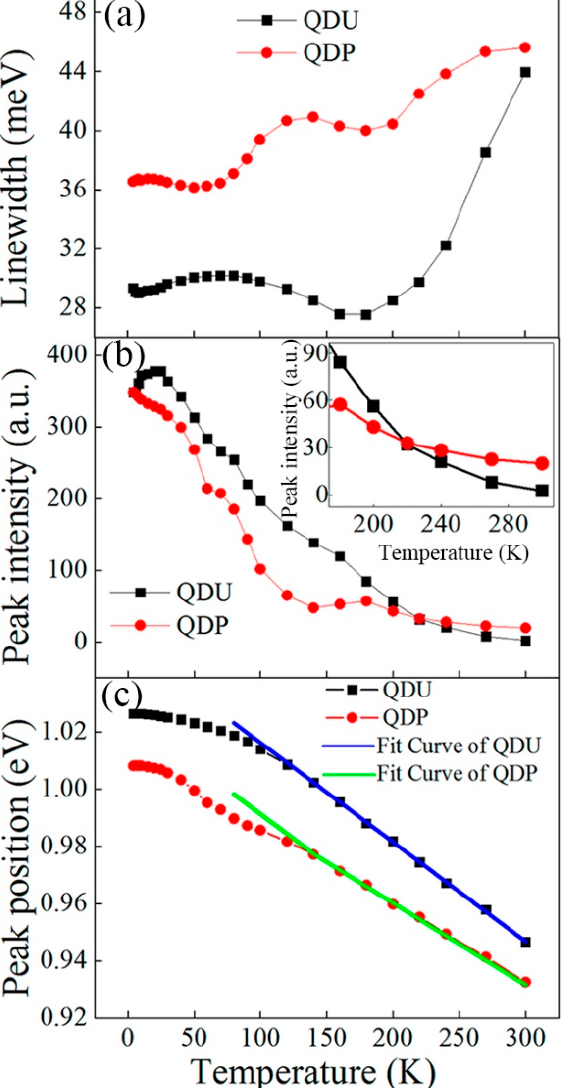
Figure 11. ( a ) PL line width, ( b ) PL peak intensity, and ( c ) PL peak position as functions of temperature. Reproduced with permission from [78]. American Chemical Society, 2018.